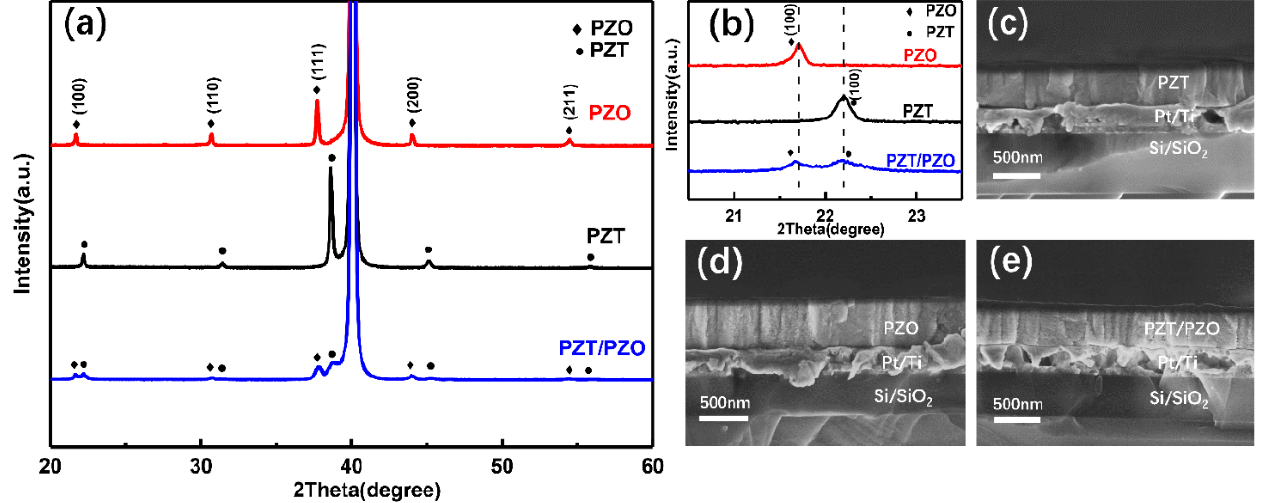
Figure 2. ( a ) XRD patterns of PZT, PZO, and PZT/PZO multilayer films grown on Pt(111)/Ti/SiO2/Si with linear y-scale at room temperature; ( b ) magnified XRD patterns around 2 θ = 22; cross-section images of ( c ) PZT, ( d ) PZO, and ( e ) PZT/PZO multilayer films.